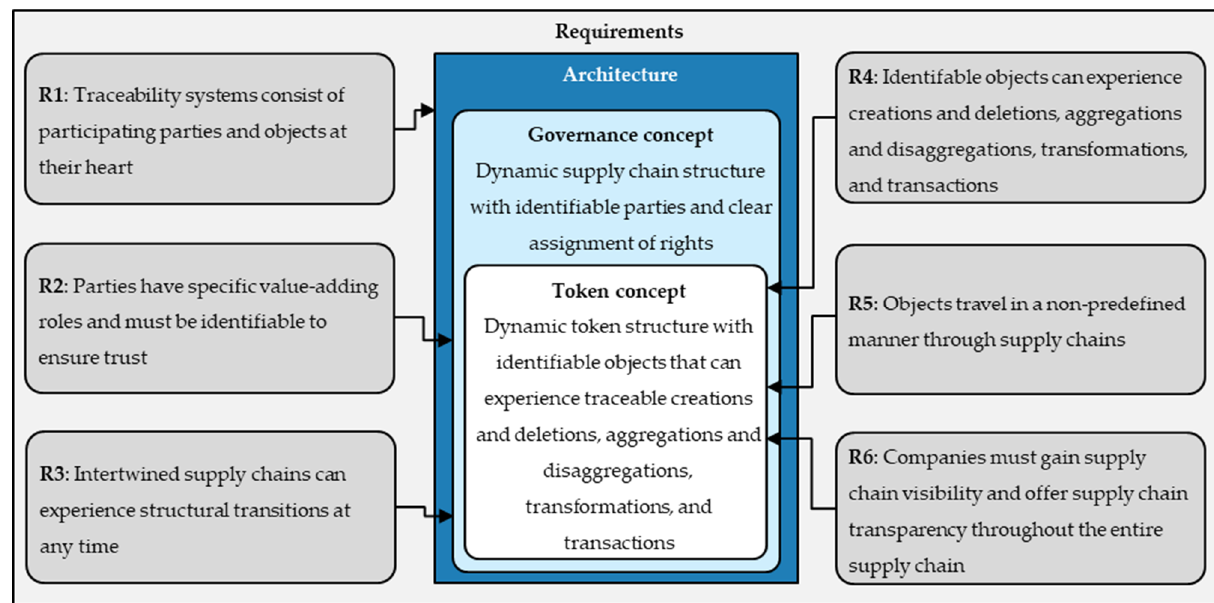
Figure 2. Architectural requirements and initial design suggestion.